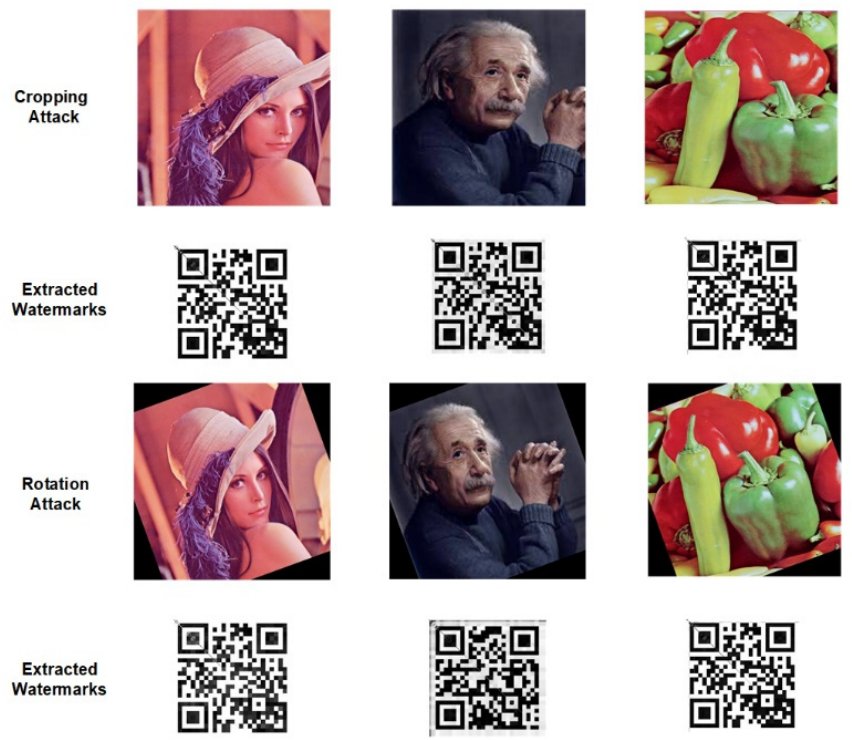
Figure 9. Geometric attacks on sample images and extracted watermarks.